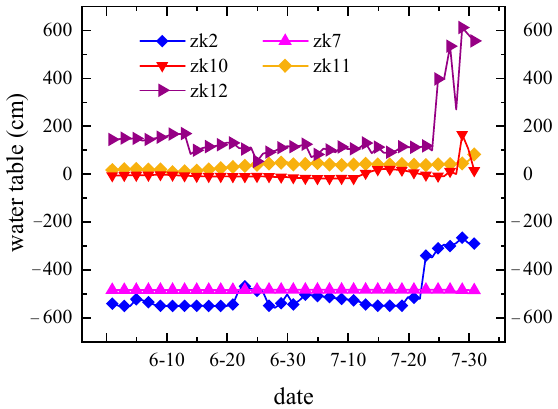
Figure 7. The underground water level variations.